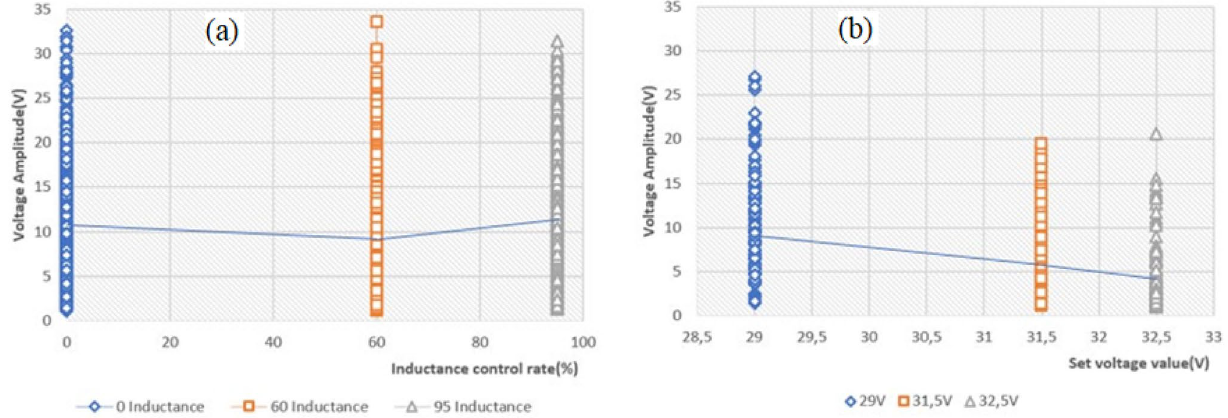
Fig. 10 Graphical representation of voltage amplitude vs set voltage value and inductance control rate: a . voltage amplitude vs set induct- ance control rate; b . voltage amplitude vs set voltage value